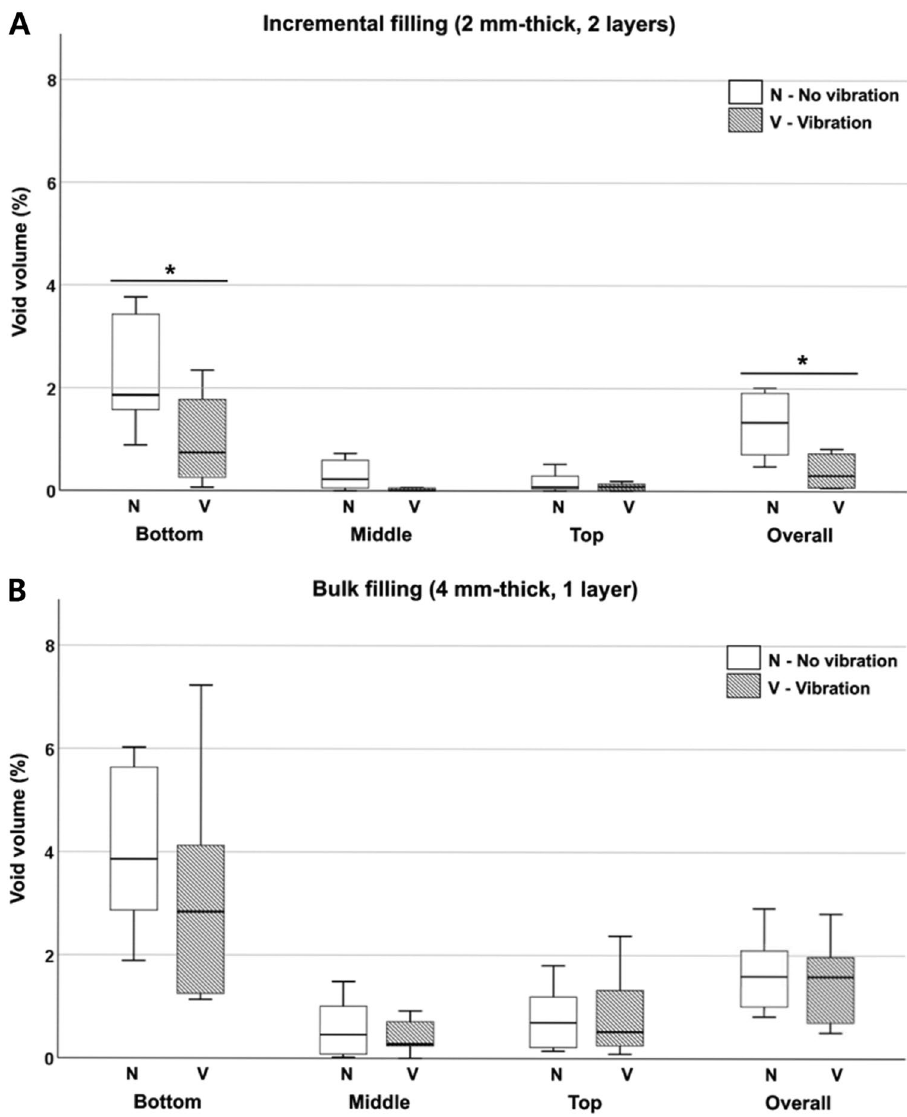
Figure 6. Void volume (%) in ( A ) incremental fillings and ( B ) bulk fillings with or without vibration in different cavity